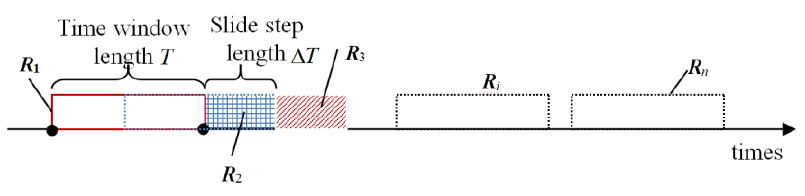
Figure 5. Method to update time window.